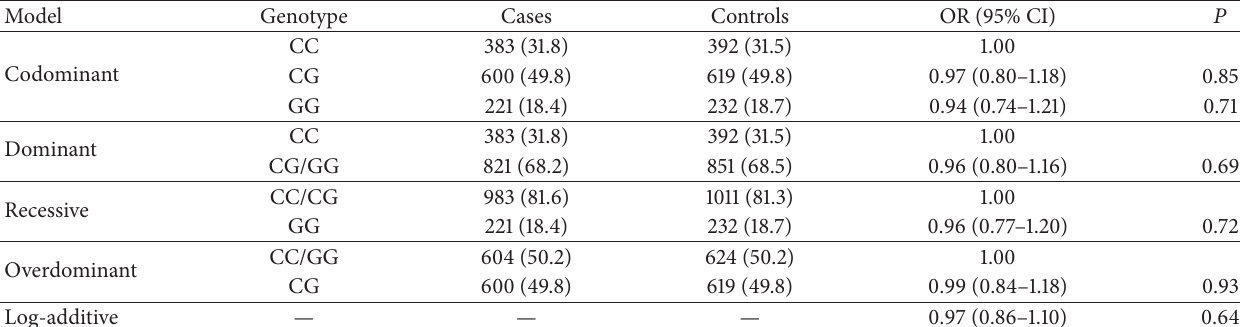
Table 3: Association between rs2910164 genotypes and PTC under different models of inheritance (adjusted by age and gender).